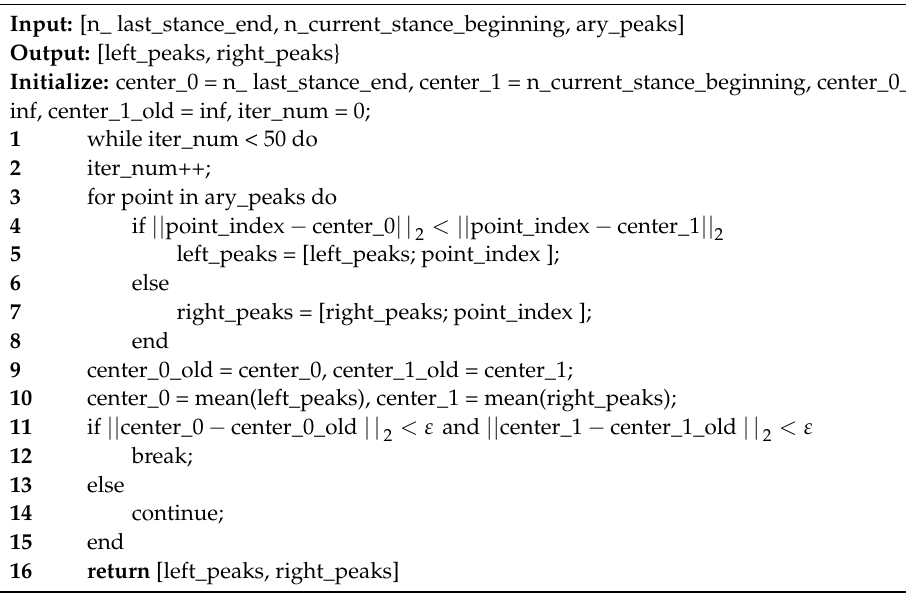
Algorithm 1: Peak-points clustering pseudo